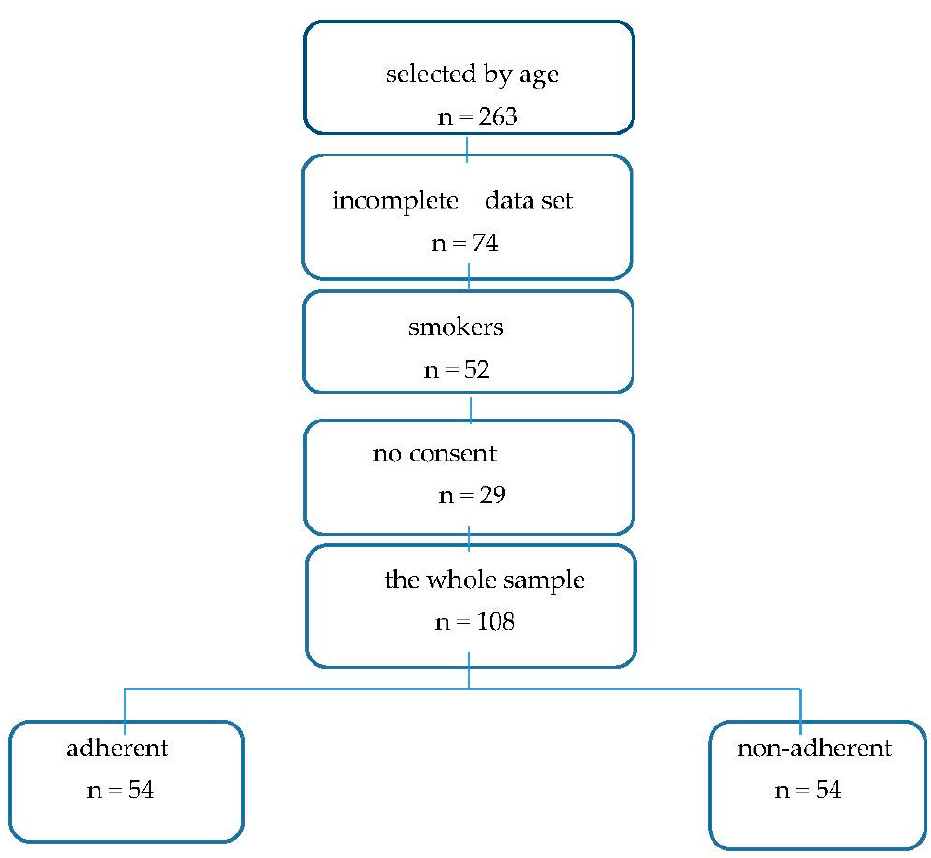
Figure 1. The consistency of the sample.